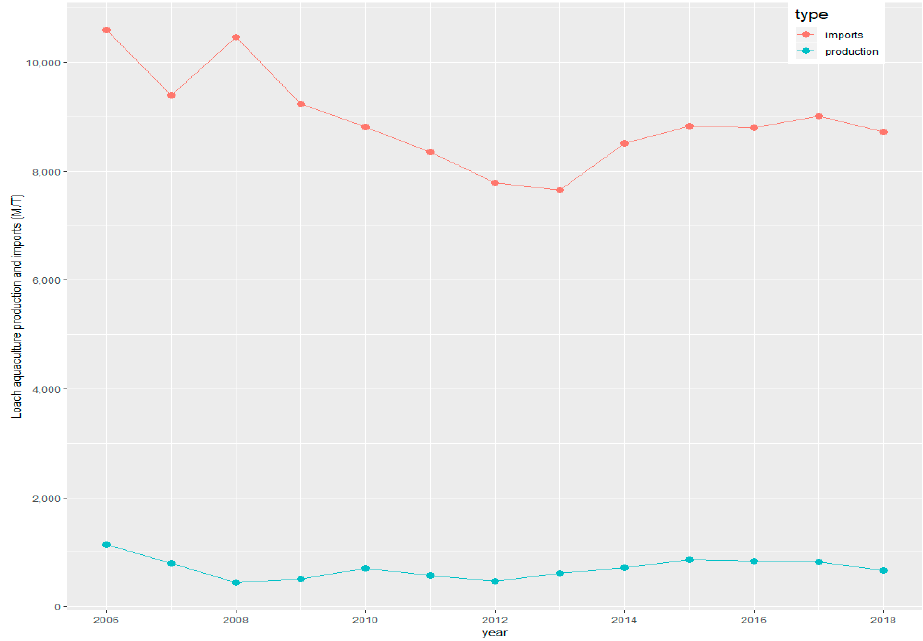
Figure 4. Loach aquaculture production and imports; Source: [26].